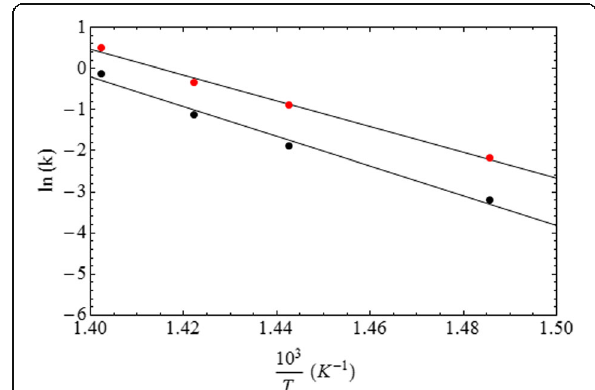
Fig. 5 Arrhenius plot for pure PVP (black points) and nano-Pd/PVP samples (red points)